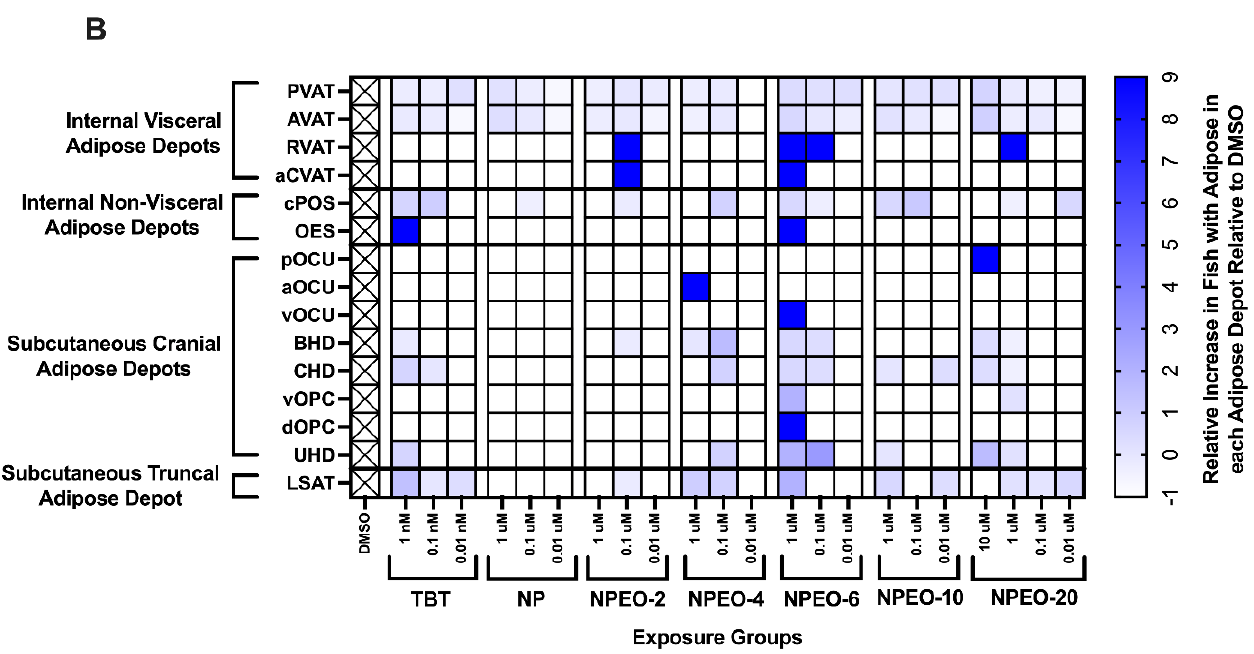
Figure 5. Adipose Deposition in Zebrafish Developmentally Exposed to Nonylphenol and Polyethoxy- lates. Zebrafish were developmentally exposed to control chemicals, nonylphenol, or nonylphenol polyethoxylates; aged to 30 days post-fertilization; then measured and stained with Nile Red (0.5 µ g/mL) for 30 min. Total body fluorescence ( A ) was imaged at 16 × magnification using a yellow fluorescent protein filter (representative images in Figure 6) and fluorescence was quantified for each fish and then biological replicates were averaged. n = 24 (DMSO), 16, 21, 25, 15, 20, 24, 14, 21, 25, 15, 25, 27, 22, 28, 25, 22, 27, 26, 25, 23, 26, and 25 across four spawning events (biological replicates) for exposure groups listed below, respectively. * indicates significant increase in total body fluorescence quantification over vehicle control fish, p < 0.05, as per Kruskal–Wallis test with Dunn’s multiple comparisons. # represents p < 0.10, as per statistics described above. Box and whisker plots depict the following metrics: whiskers represent 10–90th percentiles, box bounds represent the 25th to 75th percentiles, and the middle line represents the median. Developmental trajectory of adipose depots across the zebrafish ( B ). Relative proportions of fish exhibiting fluorescing adipocytes in each depot in the DMSO fish were set as “normal” and the heat map depicts increased proportions of fish in each group with visible adipocytes in each depot. Adipose depots labeled as per the developmental guides provided in Minchin and Rawls, 2017 (PMID: 28348140) and grouped based on anatomical classifications. A value of 9 represents a 9X increase in the proportion of fish in an exposure group PVAT = pancreatic visceral adipose tissue; AVAT = abdominal visceral adipose tissue; RVAT = renal visceral adipose tissue; aCVAT = anterior cardiac visceral adipose tissue; cPOS = central paraosseal non-visceral adipose tissue; OES = esophageal non-visceral adipose tissue; LSAT = lateral truncal adipose tissue; pOCU = posterior ocular adipose tissue; aOCU = anterior ocular adipose tissue; vOCU = ventral ocular adipose tissue; BHD = basihyal hyoid adipose tissue; CHD = ceratohyal hyoid adipose tissue; vOPC = ventral opercular adipose tissue; dOPC = dorsal opercu- lar adipose tissue; and UHD = urihyal hyoid adipose tissue. DMSO = dimethylsulfoxide, vehicle control; TBT = tributyltin chloride; NPEO = nonylphenol polyethoxylated (with varying average ethoxylate chain